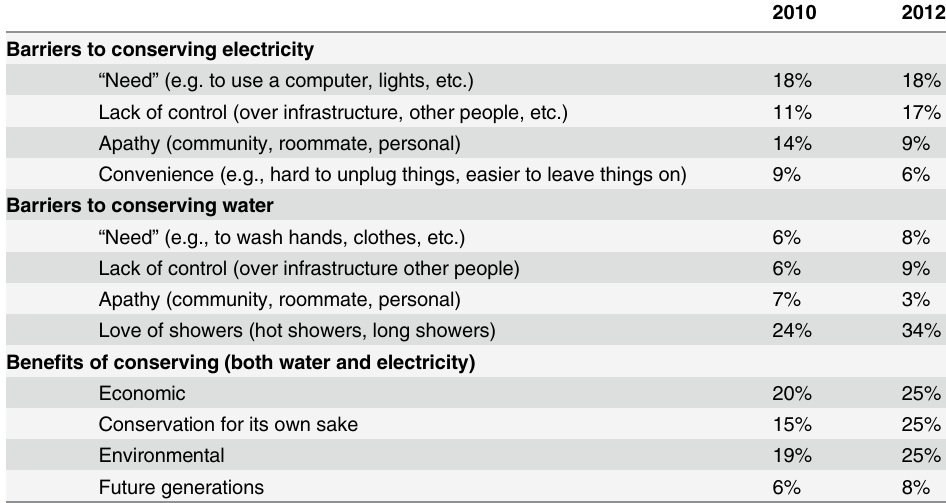
Table 7. Perceived barriers and benefits to conserving water and electricity. Categories were created after reviewing text of survey responses to identify common factors. Percentages are the percent of survey takers who offered responses that fall into each